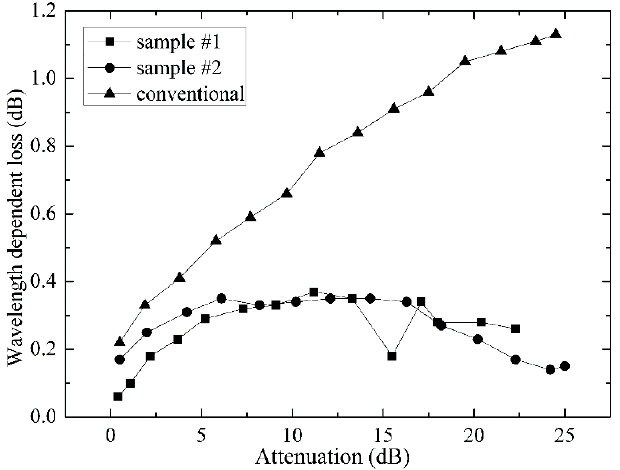
Figure 9. Measured WDL over the C-band at different attenuation levels.